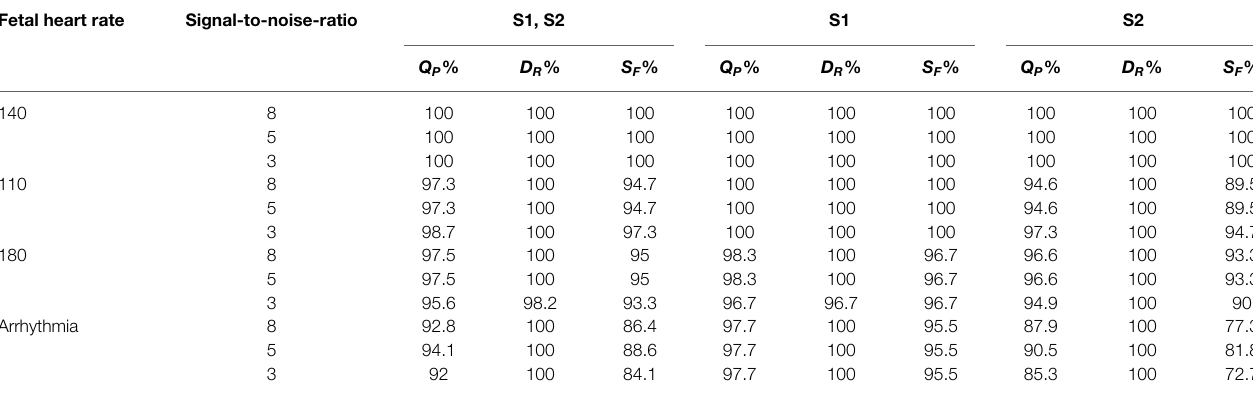
TABLE 1 | Performance of the wavelet transform–fractal dimension filter for cases of simulated fetal phonocardiograph signals created by Hadjileontiadis. Fetal heart rate